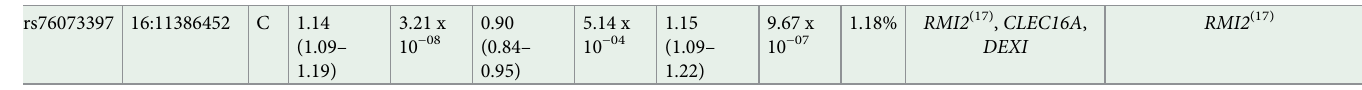
We found that the genetic associations in signal-B tagged by rs34725611 and rs11085727 colocalize with a TYK2 eQTL signal in whole blood in eQTLGen [14] ( Fig 4B ) and GTEx v8 data, and adrenal gland in GTEx v8 data: PP > 0.98 for colocalisation between the two traits H4 and with all eQTL signals ( Fig N in S1 Text ). eQTL summary statistics can be seen in Table G in S1 Text, where the associated allele effects can be compared across traits and eQTL. In all